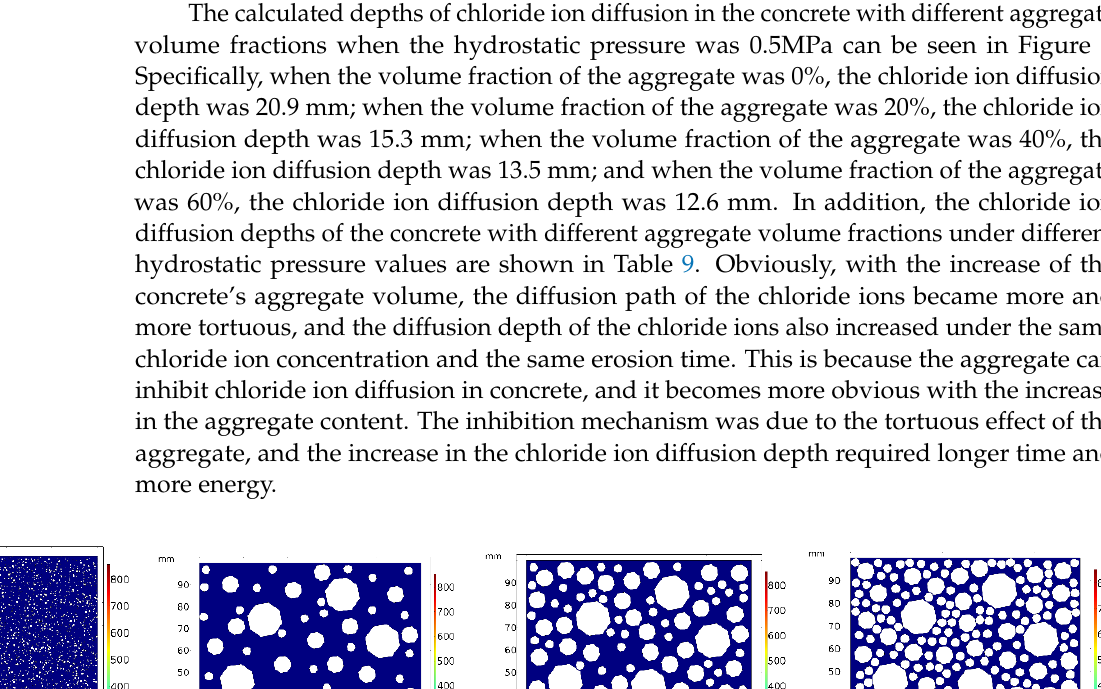
Figure 5. Test results of chloride ion diffusion under different volume fractions of the aggregate under a hydrostatic pres- sure of 0.5 MPa.